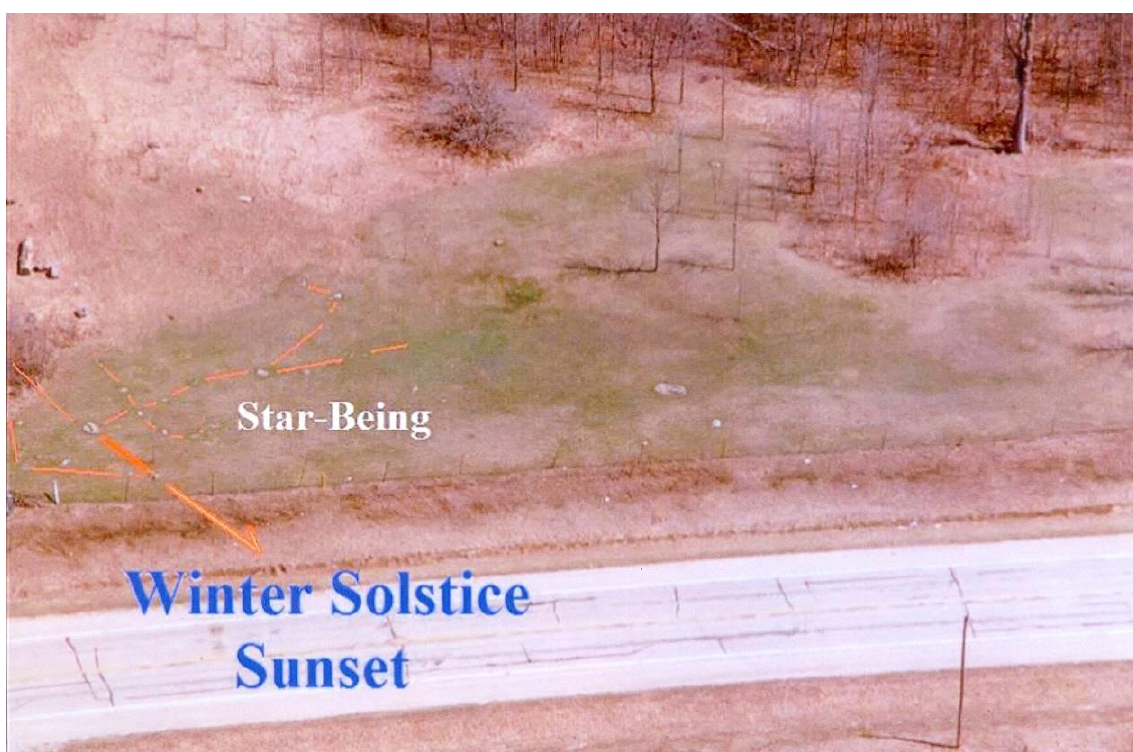
Figure 26. Aerial view of the Star-Being lithic outline or petroform with ‘helper lines’ and the direction of the winter solstice sunset viewed overlooking the aligned, bison-shaped headstone and an aligned rock (see Figure 27). Road construction likely destroyed others in the